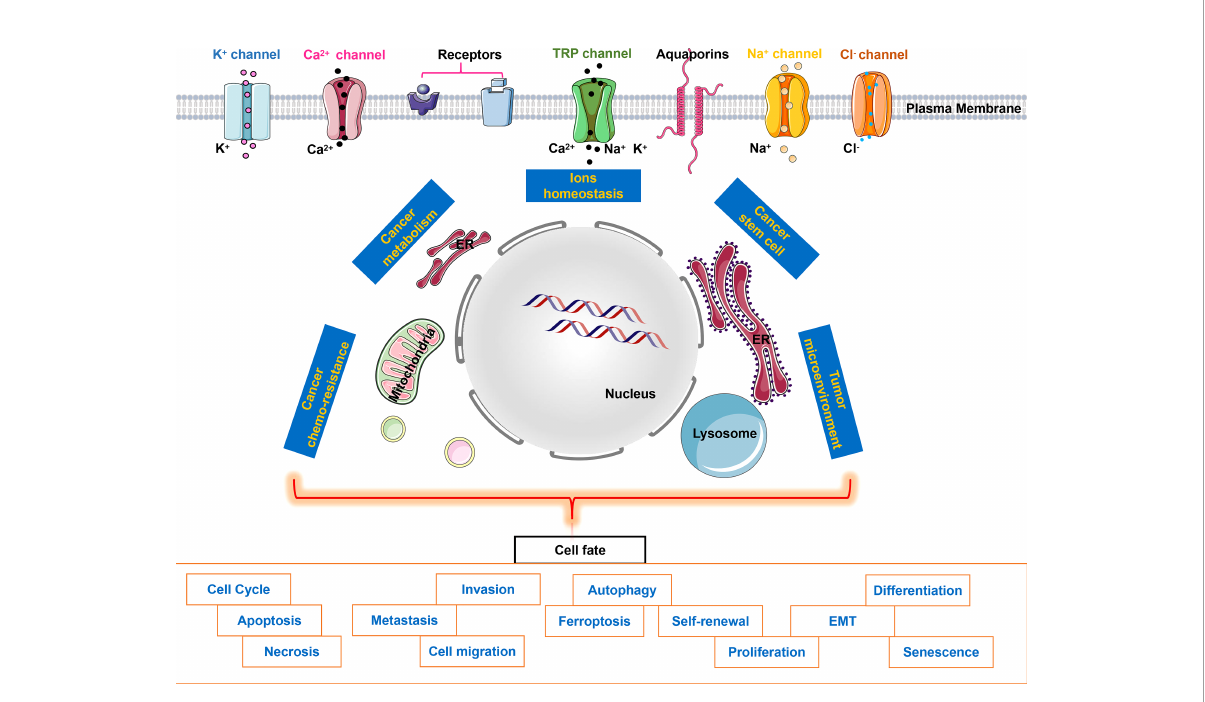
FIGURE 1 Ion channels & ion homeostasis in cancer cell fate. Intracellular ion fl uctuations triggered by speci fi c stimuli of ion channels activate downstream signaling cascades, which affect ions homeostasis, cancer metabolism, cancer stem cell, cancer chemo-resistance or tumor microenvironment, therefore determining cancer cell fate